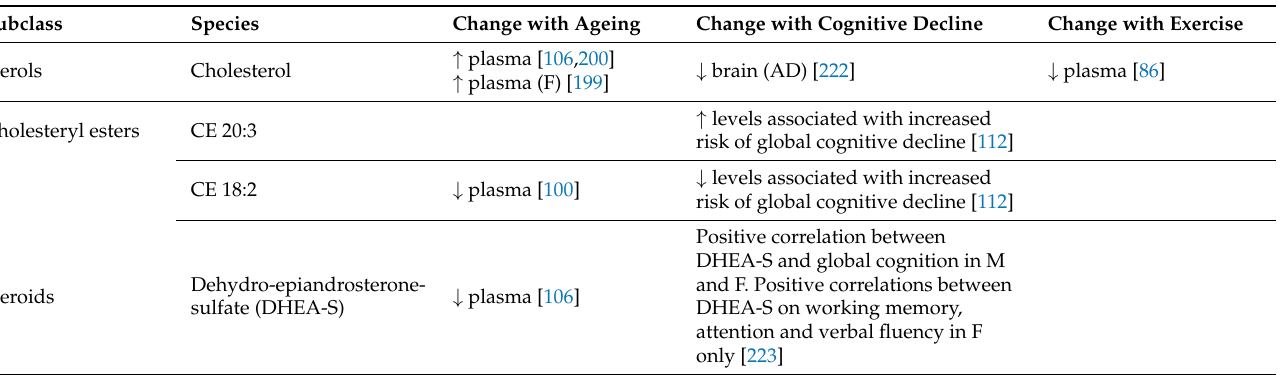
Table 5. Changes in sterols with ageing, cognitive decline and